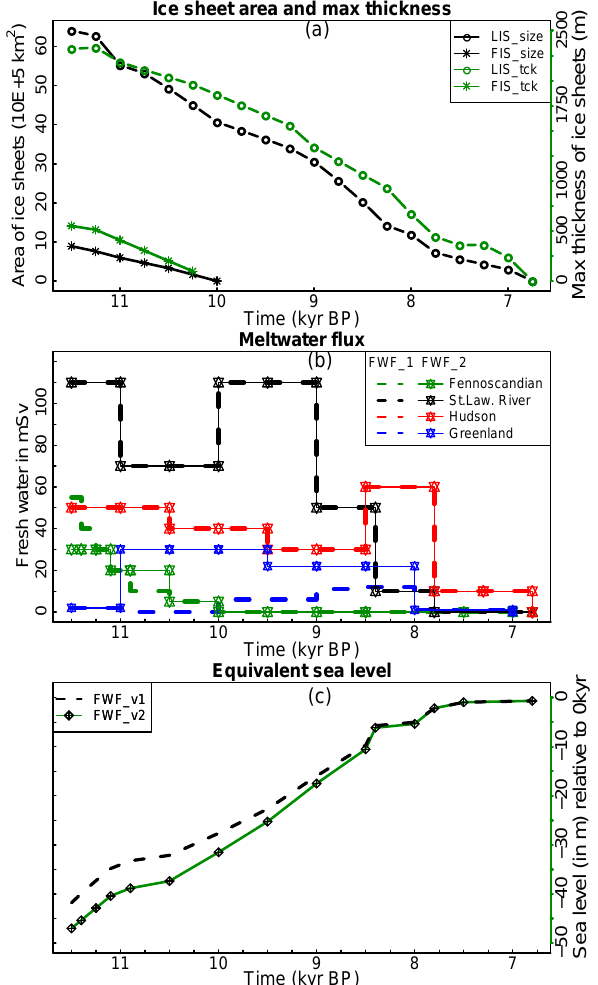
Figure 2. The prescribed ice-sheet forcing during the early Holocene. (a) Variation in ice-sheet extent (km 2 ) displayed as the black lines with the axis on the left and their maximum thickness (m) indicated by the green lines with the axis on the right. A rel- atively minor change in GIS is not shown due to its small scale. (b) Two freshwater flux scenarios (in mSv), FWF-v1 (thick dashed lines) and FWF-v2 (solid lines). (c) Total meltwater discharge in equivalent sea level